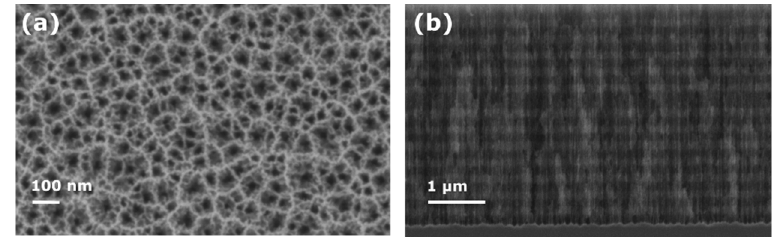
Figure 2. Porous silicon microcavity. ( a ) Top view and ( b ) cross-sectional view SEM images of PSi microcavity.